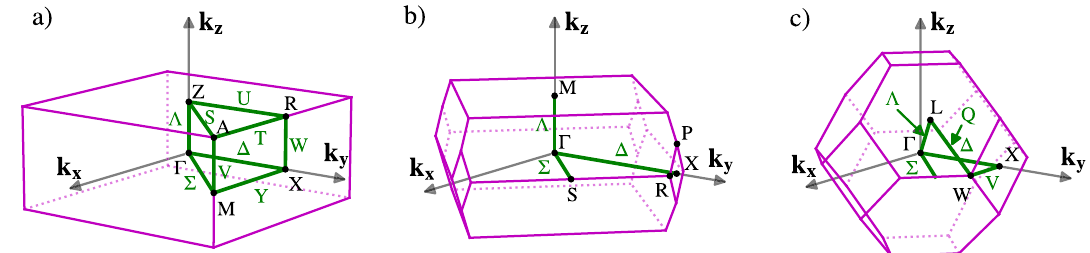
Figure 1. First Brilliouin zones and labels of higher symmetry points and directions, with respect to 18 . ( a ) Simple tetragonal lattice (CePd 2 Al 2 ). ( b ) Body centered tetragonal lattice (CeCuAl 3 ). ( c ) Reciprocal body centered cubic lattice (CeAl 2 -direct face centered